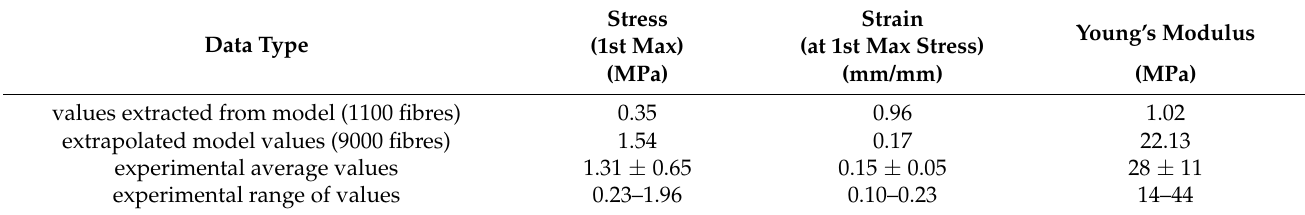
Figure 5. ( Top ) Appearance of electrospun nanofibrous nonwoven sheet of PEO obtained with SEM, magnification 2000 × ( a ) and 10,000 × ( b ). Regular structure of fibres is visible as well as fibrous rough edges of single fibres. ( Bottom ) The same electrospun sample after rupture in tensile test shown in the middle region at 2000 × magnification ( c ) and at the edge with 500 × magnification ( d ). Table 2. Comparison of experimental, model and extrapolated mechanical properties of electrospun